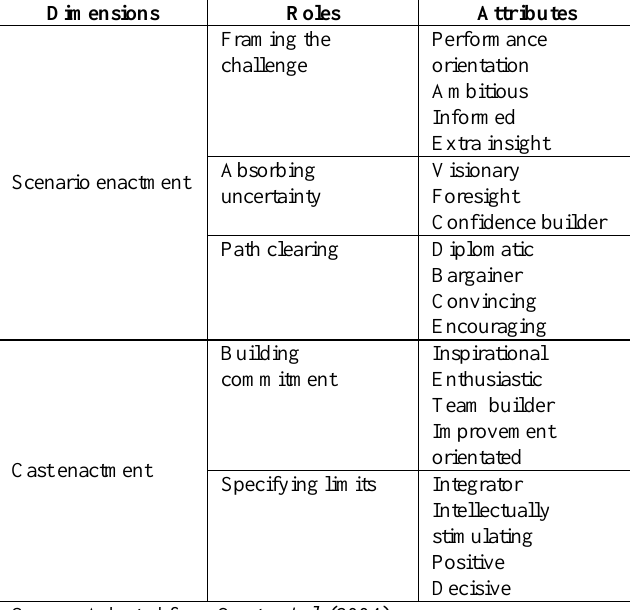
Table 1: Entrepreneurial leadership